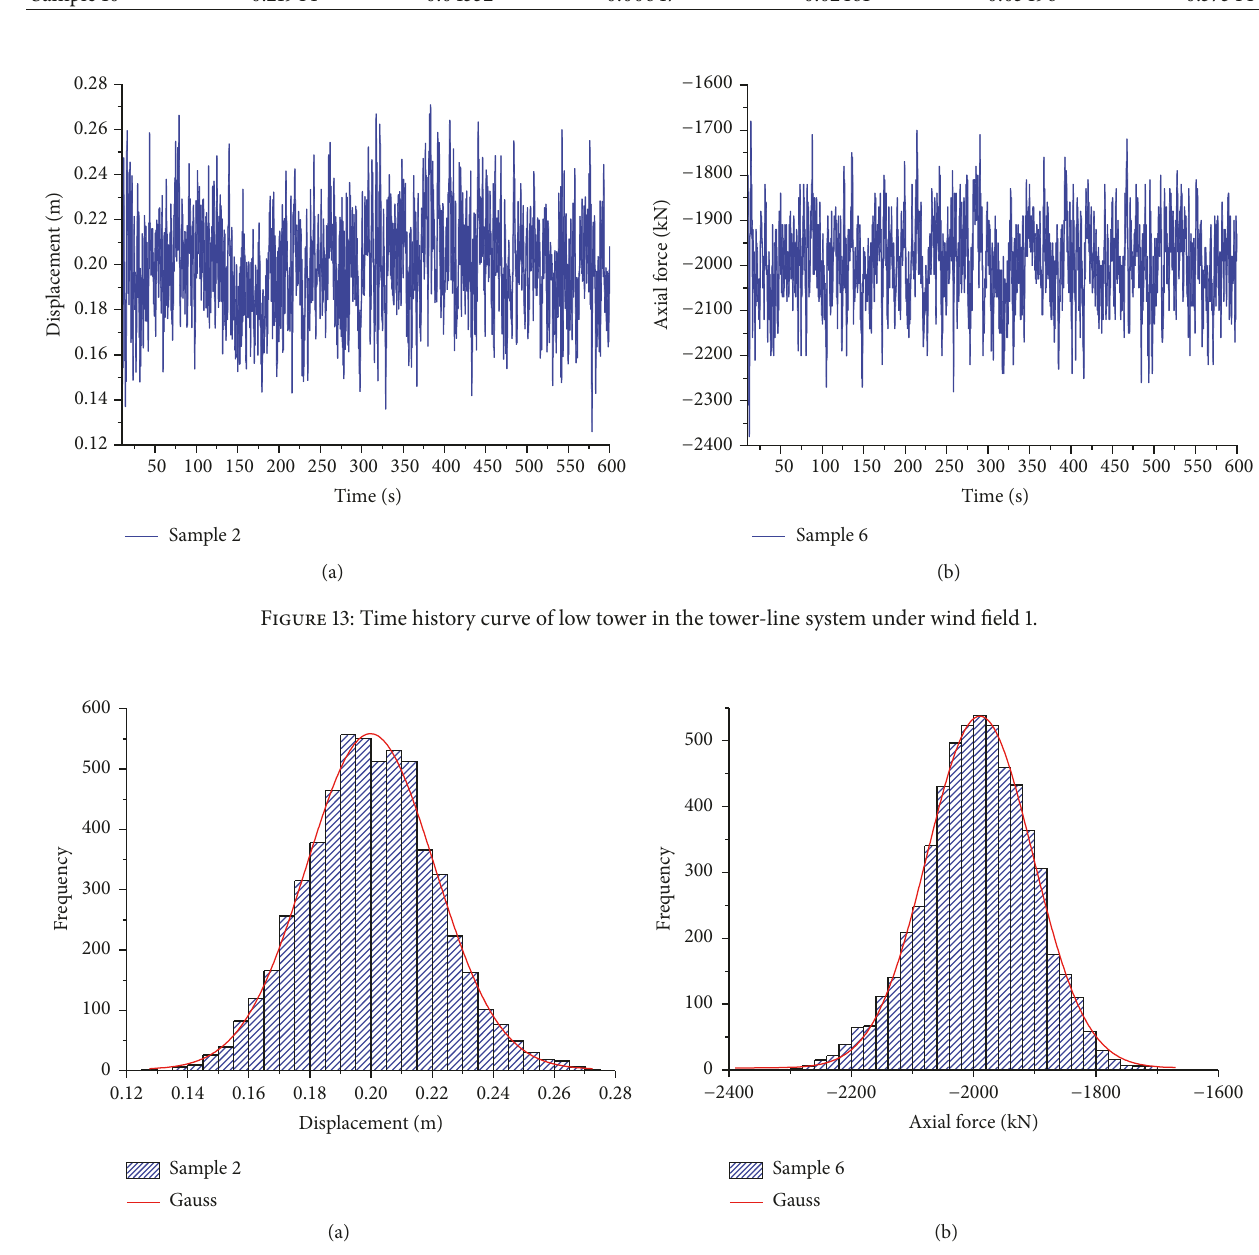
Figure 14: Frequency histogram of low tower in the tower-line system under wind field